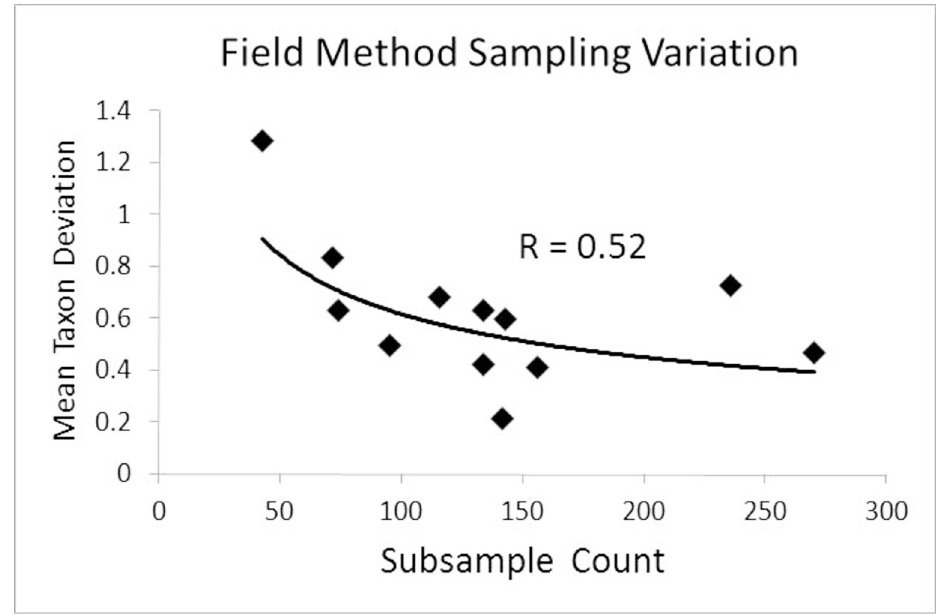
Fig 3. Mean taxon deviation of the Field method as a function of subsample count.